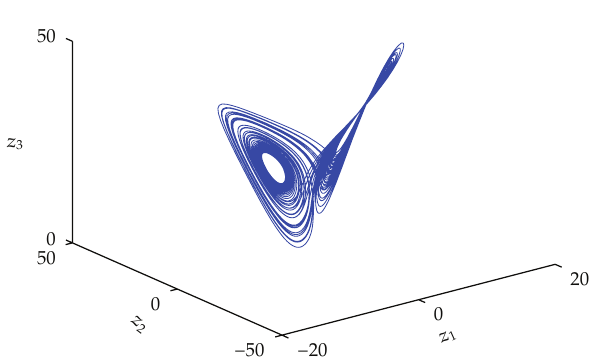
Figure 1: Chaotic attractors of the fractional-order Lorenz system (cid:2) 3.6 (cid:3) for q r (cid:7) 0 .